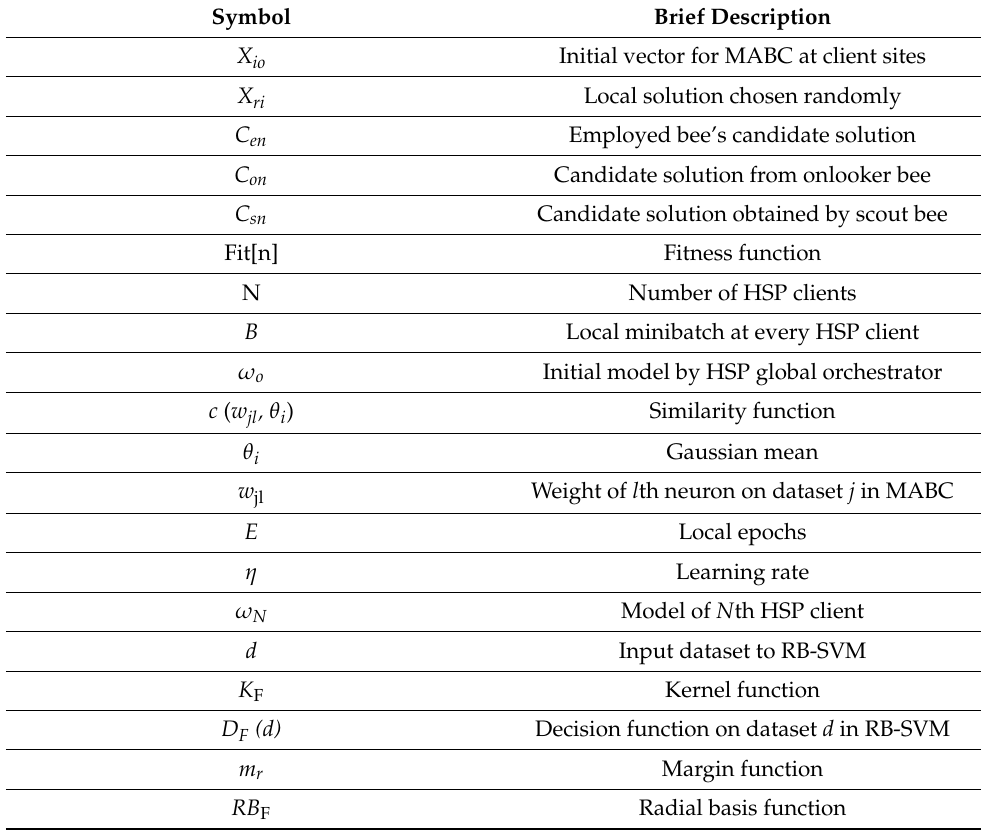
Table 1. Brief description of the symbols utilized in our proposed